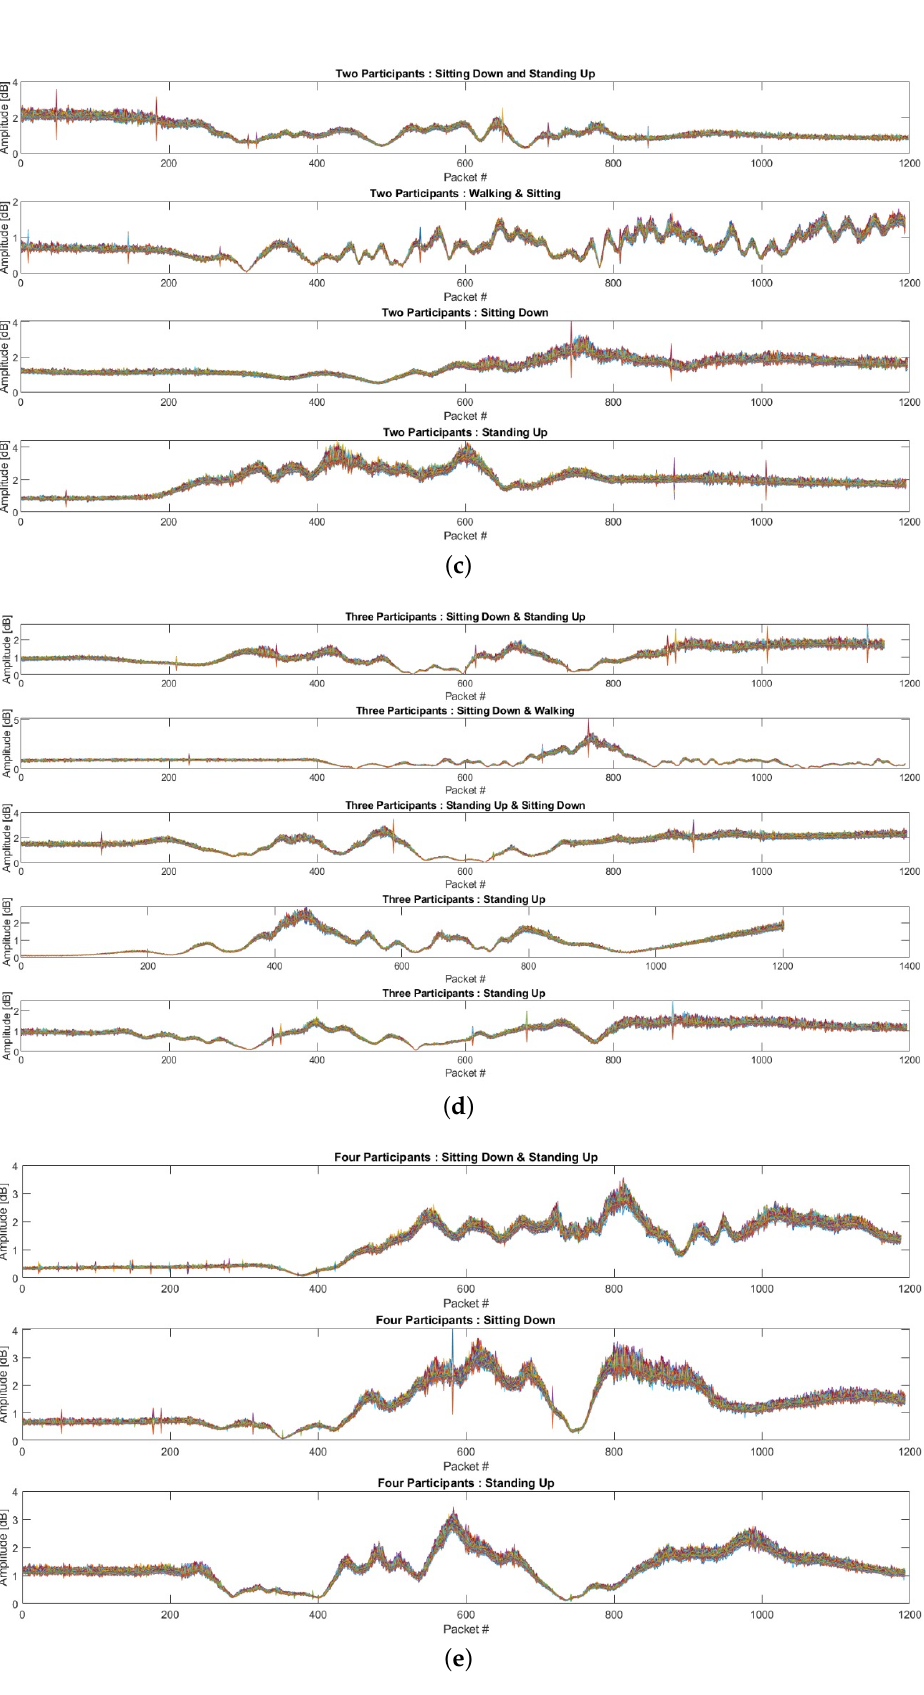
Figure 3. Samples of obtained CSI data from different activities: ( a ) no participant (empty